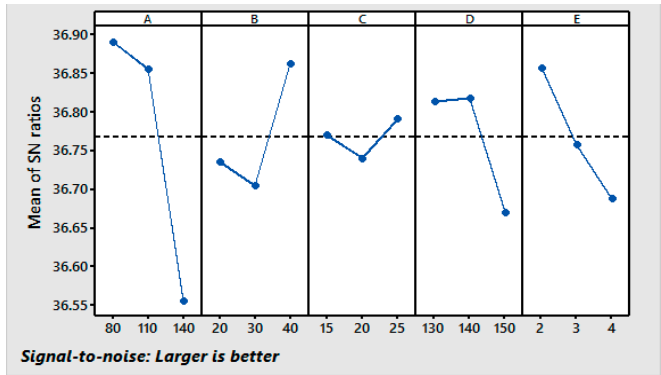
Figure 3. Main effect plots for the S/N ratios [Response: WI].